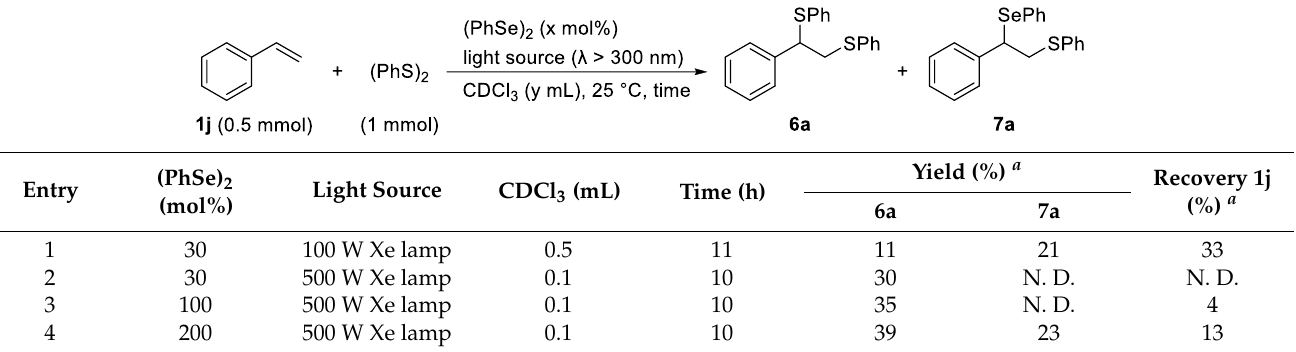
Table 2. Attempted dithiolation of styrene 1j assisted by (PhSe) 2 .